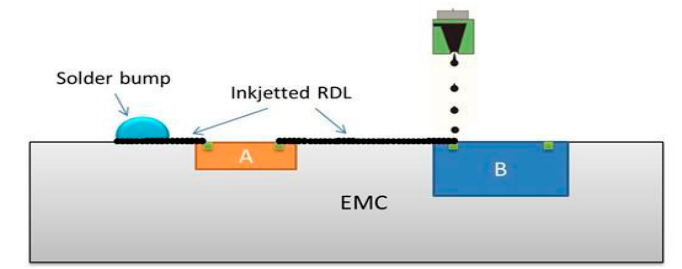
Figure 2. Schematic demonstration of inkjet-printed RDLs for a SiP